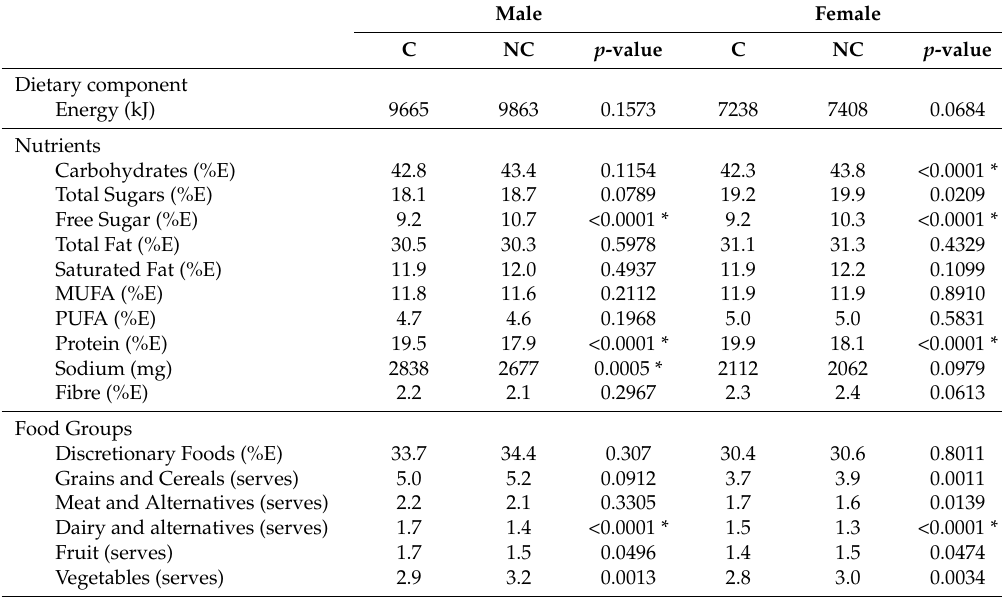
Table 4. Dietary intake of adults (aged 19 years and over) NNS consumers and